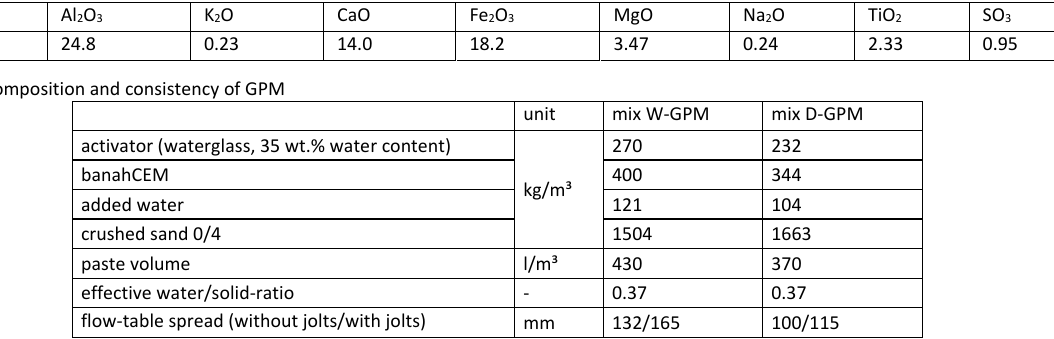
Table 1. Chemical composition of the metakaolin/GGBFS binder (“banahCEM”) in wt.% SiO 2 Al 2 O 3 K 2 O CaO